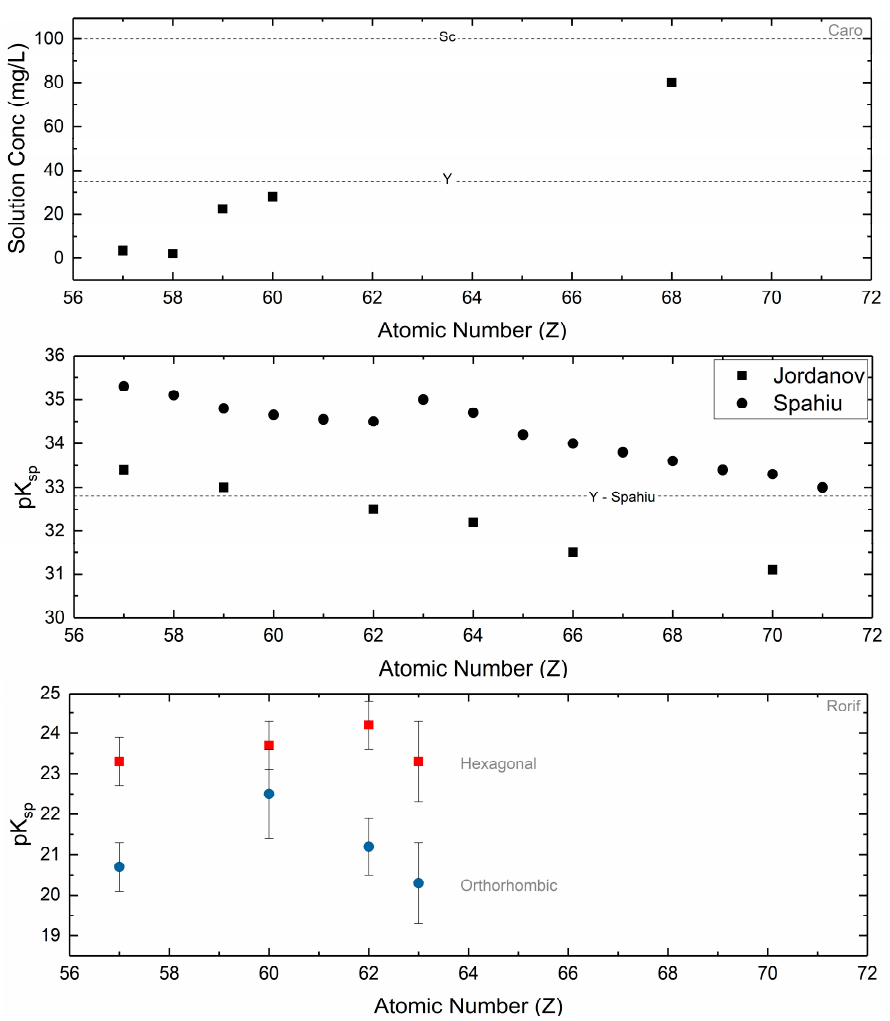
Figure 9. Solubility products and raw data for the normal carbonates are presented from Caro and coworkers [48], Jordanov [141], and Spahiu [142]. In general, the solubility of the normal carbonates increases with increasing atomic number. The dotted lines are the values for scandium carbonate and yttrium carbonate as reported by the respective authors and are presented for reference. Solubility products for the hexagonal and orthorhombic hydroxycarbonates are from Rorif [127]. No trend with respect to atomic number may be established, but the orthorhombic carbonates are in general more soluble than their hexagonal counterparts.